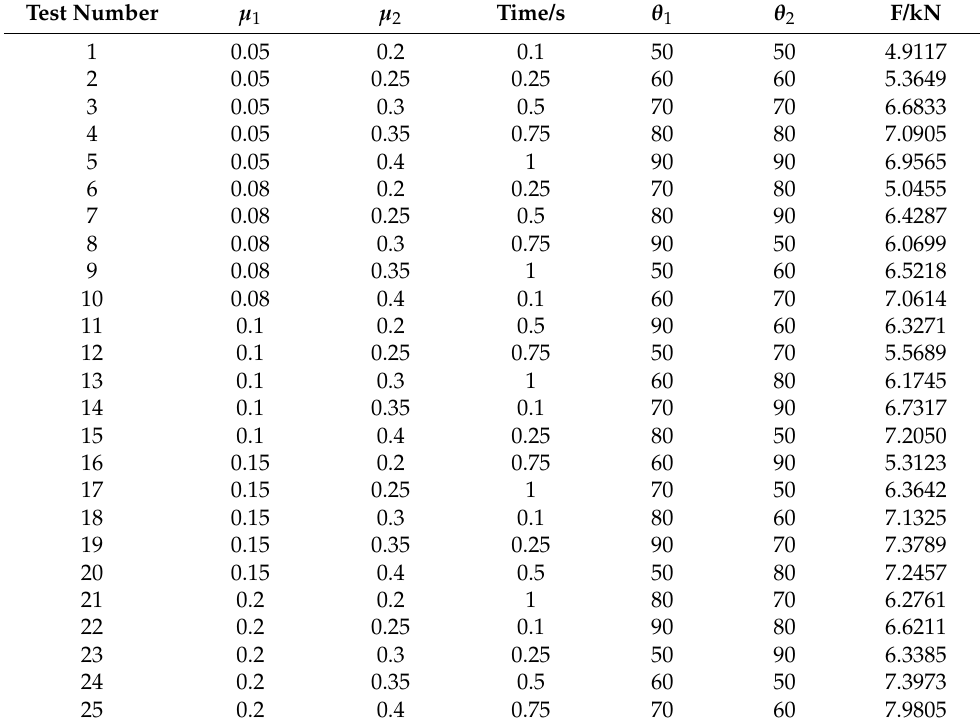
Table 3. Results of orthogonal